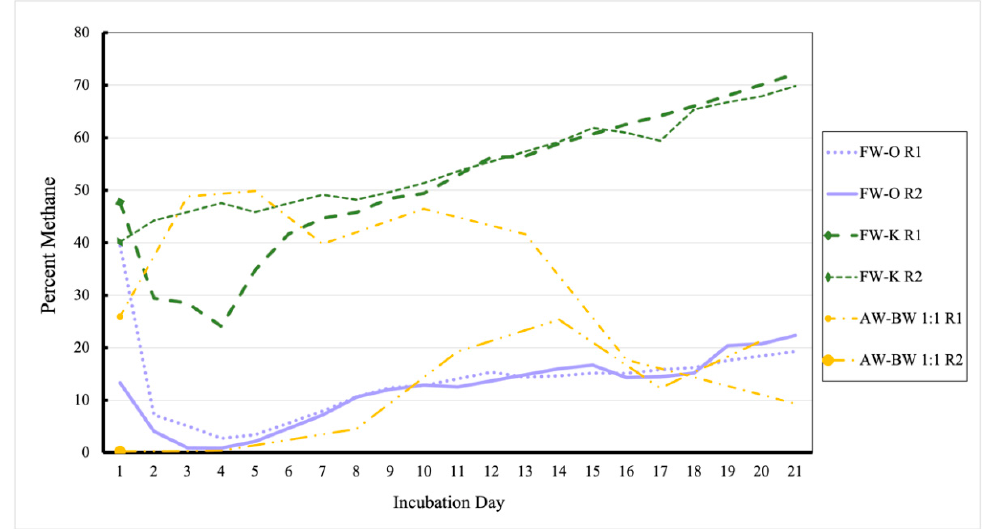
Figure 2. Biogas quality from select feedstock mixtures throughout incubation period.